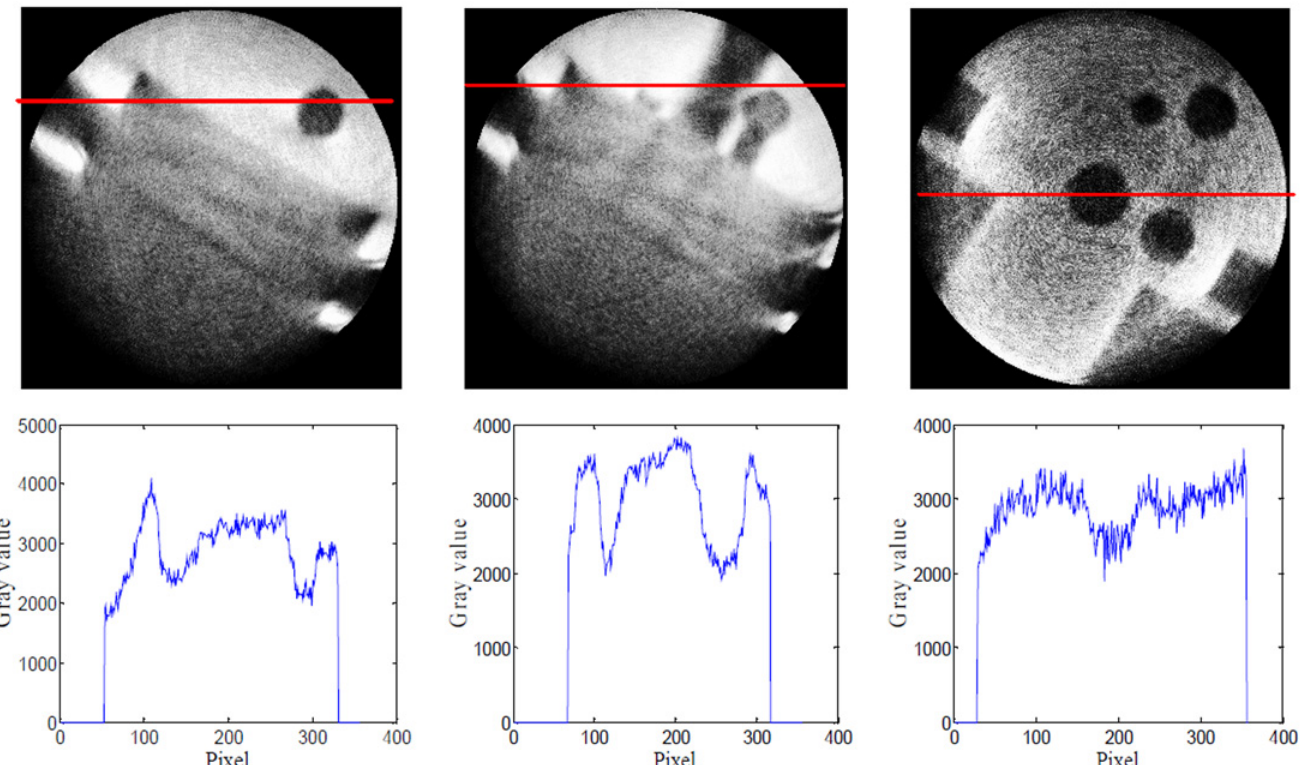
Fig 9. HDR-CT reconstruction results. The first row CT image from left to right is corresponding to bottom, center and top about workpiece, The second row is respectively the gray curve at the indicated line. In these CT image the construction is full, but the image quality is poor, and noise level is